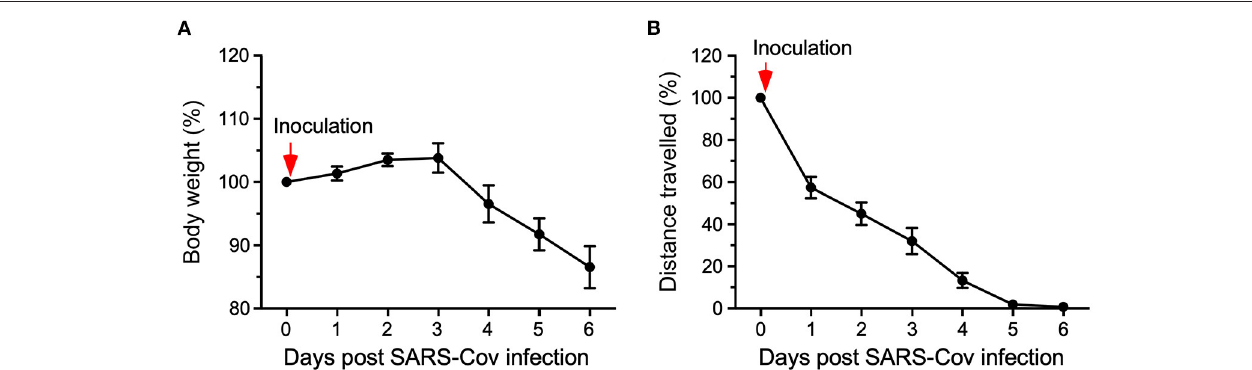
FIGURE 1 | Eight single-housed K18-hACE2 (C57Bl/6J background) mice were exposed to the SARS-CoV-2 virus (2.8 × 10 4 TCID50/ml). Changes in body weight (A) and total distance traveled (B) were assessed for six days relative to pre-inoculation values (100%). After viral exposure (inoculation), body weight dropped significantly on day 4, whereas the distance traveled was already significantly reduced by 30% on day 1 and reduced by almost 90% on day 4 indicating substantially higher sensitivity of locomotor activity than body weight change (Gaburro, 2021; modified from Kaufmann et al., 2022).